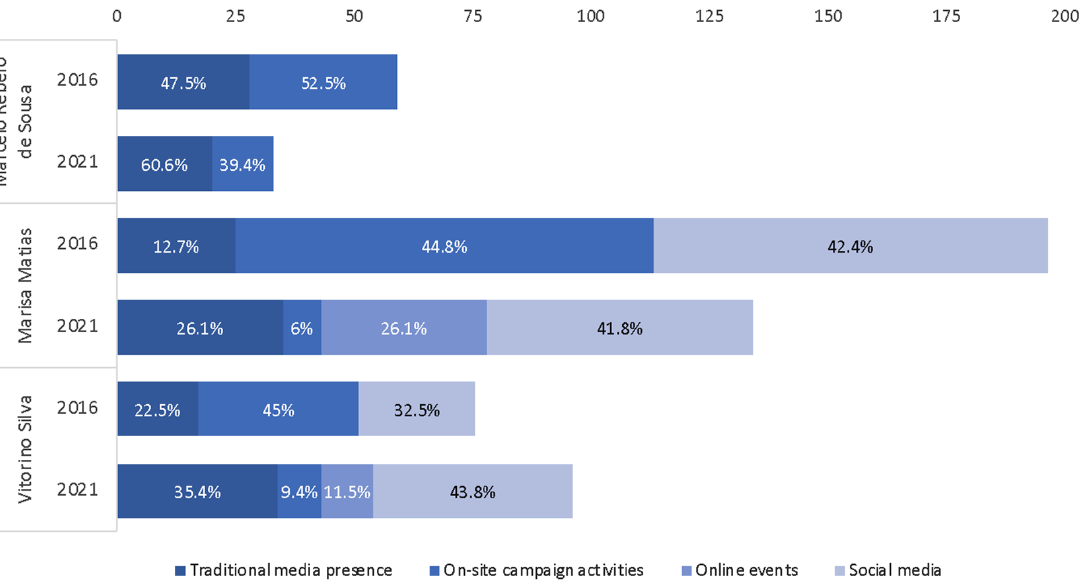
Figure 2. Traditional vs. Digital Campaigning. Comparison between candidates running in both elections. Source : Own data (see Section 3.1.1).